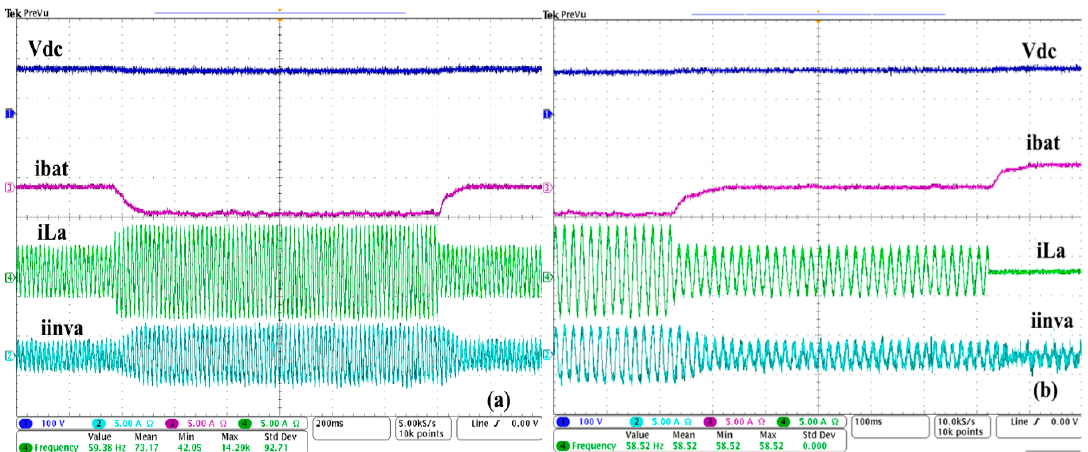
Figure 20. Experimental results under fixed solar irradiation and load change when SOC% of BES is greater than 50%: ( a ) increasing and decreasing of linear load, ( b ) decreasing of nonlinear load, and switched off the phase `a`.